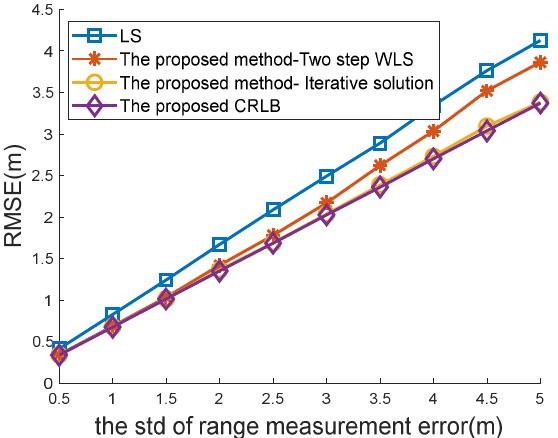
Figure 6. Comparison of the proposed methods under different TOA noises.